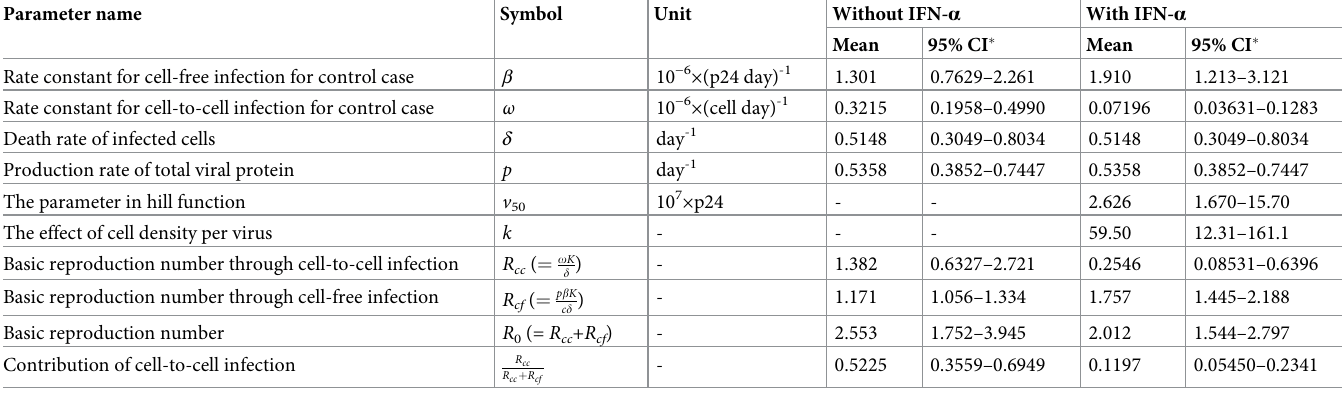
Fig 5. Dynamics of HIV-1 CH077_CC infection in static and shaking cultures without or with IFN- α . Jurkat- CCR5 cells were infected with HIV-1 strain CH077_CC at MOI 0.05 in the static and shaking cultures under treated with IFN- α or untreated. a Longitudinal experimental data and the fitting of Model 1 to the data (see Methods). The time-course of experimental data for the numbers of uninfected cells (top) and infected cells (middle), and the amount of viral p24 antigen in the culture supernatant (bottom) in the static culture (left) and shaking culture (right) are shown. Gray and orange curves respectively indicate the results in the absence or presence of IFN- α treatment. The dots with error bars are the averages and SEMs of three independent experiments. The shadow regions correspond to 95% posterior predictive intervals, and the curves give the best-fit solution Model 1 to the experimental dataset. b-e The comparison of basic reproduction numbers in the absence or presence of IFN- α . (Left) The distributions of R 0 ( b ), R cf ( c ), and R cc ( d ), computed from all the accepted parameters are shown. The contribution of cell-to-cell infection /( R + R )) is shown in panel e . (Right) The bars indicate the mean values computed by the MCMC method. (i.e. R cc cc cf Orange and gray respectively indicate the data with and without IFN- α treatment. The p values are calculated by the Brunner Munzel test. f,g Virtual simulation of cell-to-cell infection of HIV-1 strain CH077_CC. Using our estimated parameters ( Table 2 ), pure cell-to-cell infection is simulated in silico (solid curves). The simulated values are located between the time course of the experimental data under the static conditions (closed circles) where both cell-free and cell-to-cell infection can occur and those under the shaking conditions (open circles) where only cell-free infection can occur. The shadowed regions correspond to 95% posterior predictive intervals. Panels indicate the results in the absence ( f ) or presence ( g ) of IFN- α treatment, respectively. https://doi.org/10.1371/journal.pcbi.1010053.g005 Table 2. Estimated parameters fitting the experimental data of HIV-1 strain CH077_CC by Model